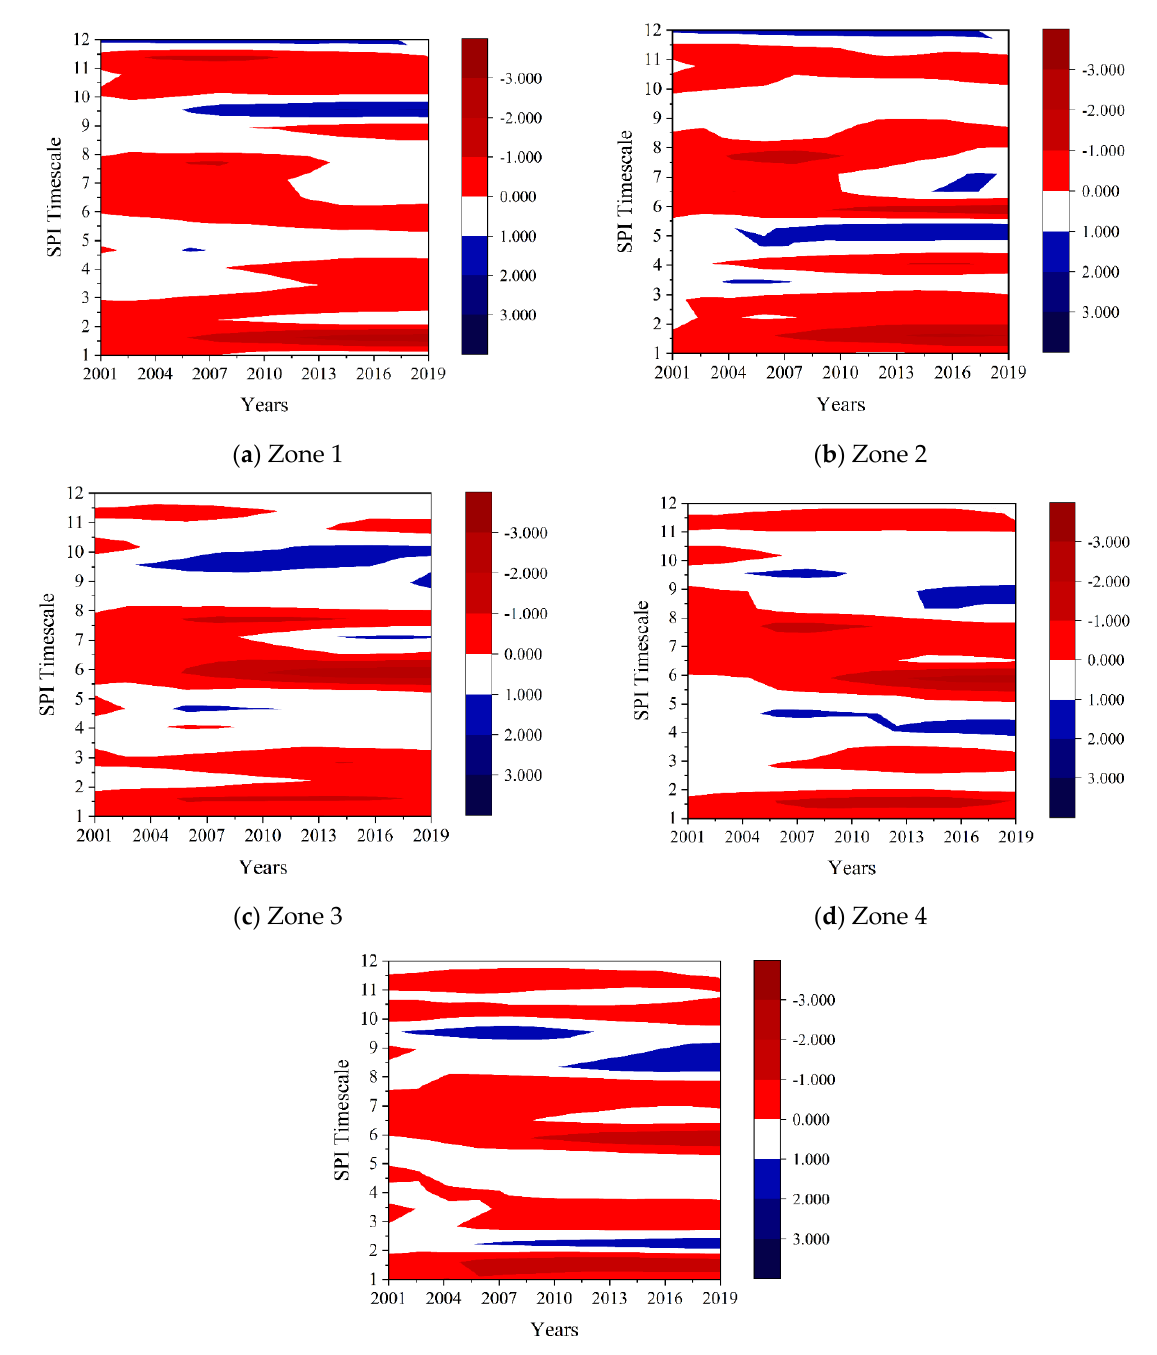
Figure 3. The temporal time series of the Standardized Precipitation Index (SPI) at 1–12-month lags in different zones of Punjab, ( a ) Zone 1, ( b ) Zone 2, ( c ) Zone 3, ( d ) Zone 4 and ( e ) Zone 5. The blue color describes the wet condition and the red color shows the dry condition.